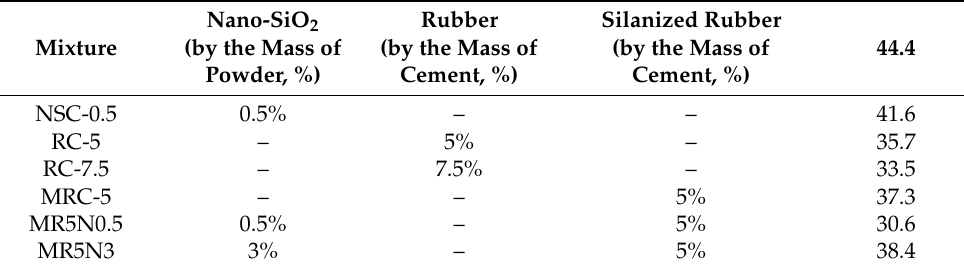
Table 4. Research parameters of designed frost-resistant